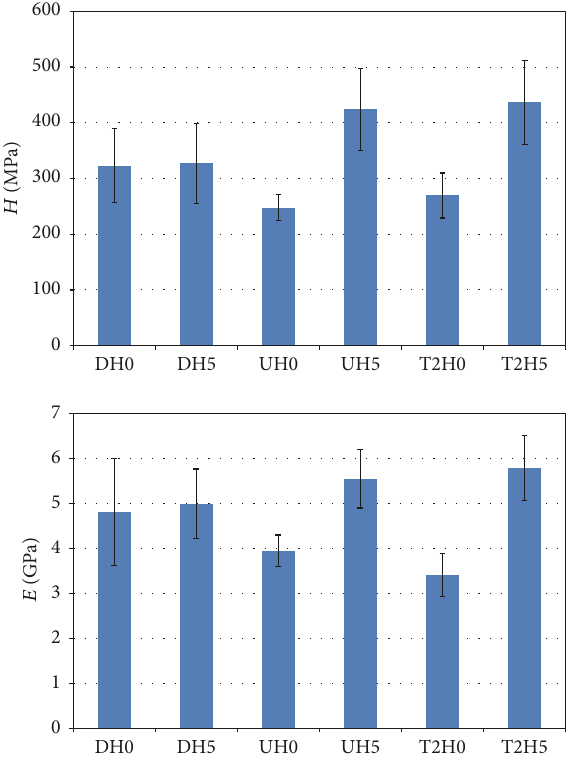
Figure 7: Hardness and elastic modulus of POM and POM nanocomposites.